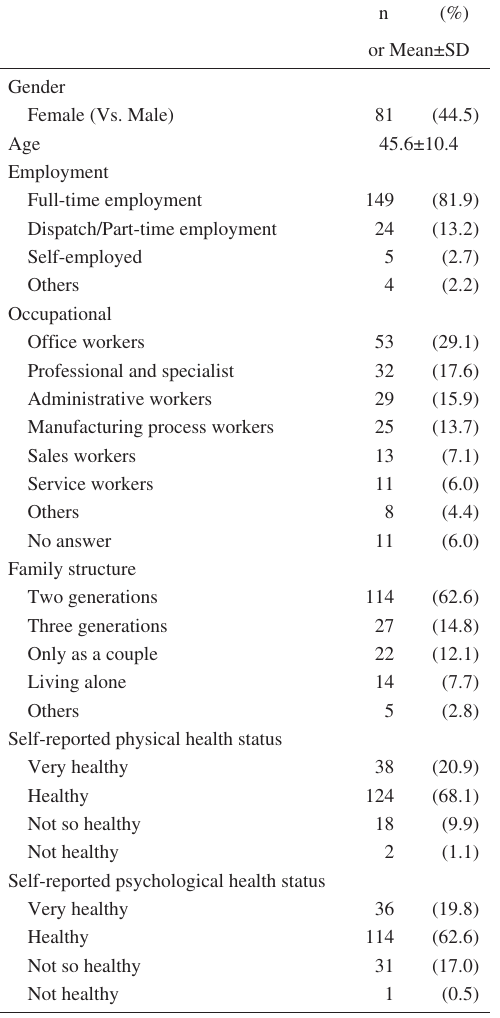
Table 1. Characteristics of respondents (n =